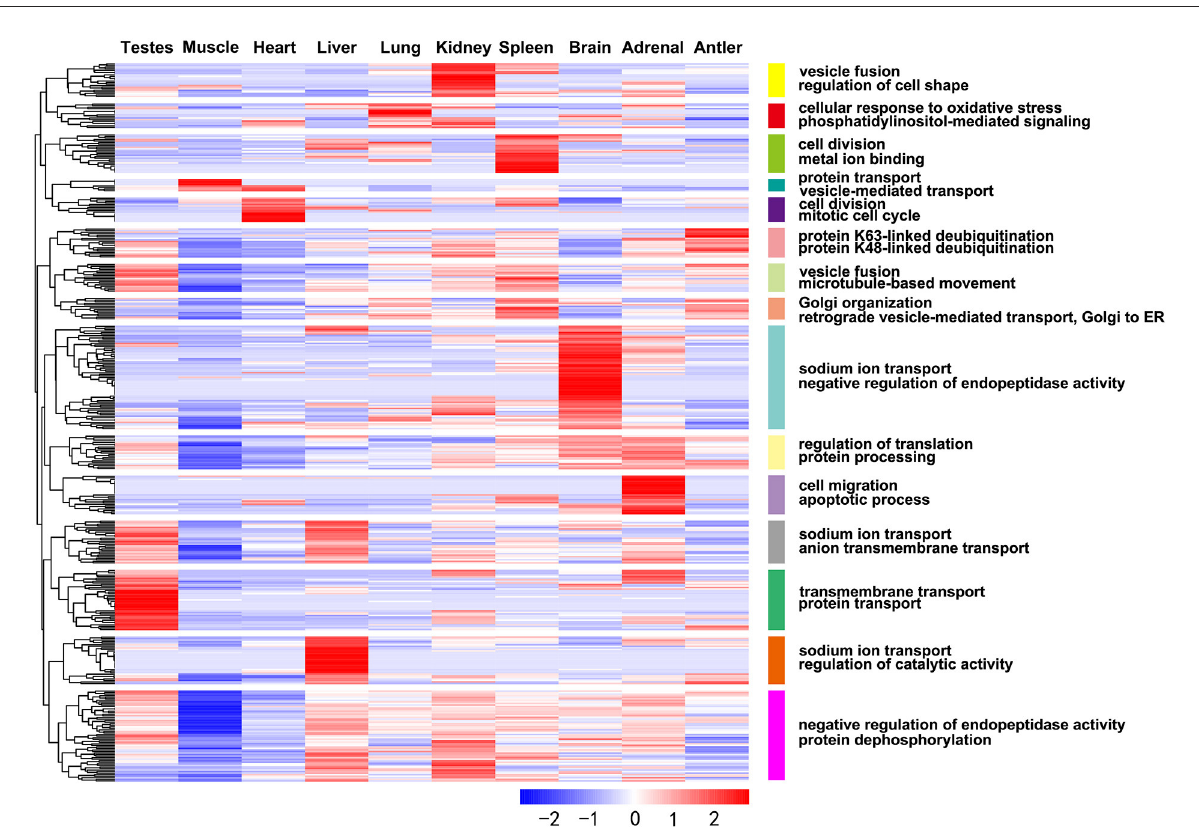
FIGURE5 Heat map showing expression profiles of the development-dependent miRNAs and their target genes with significant GO annotations using the DAVID functional annotation